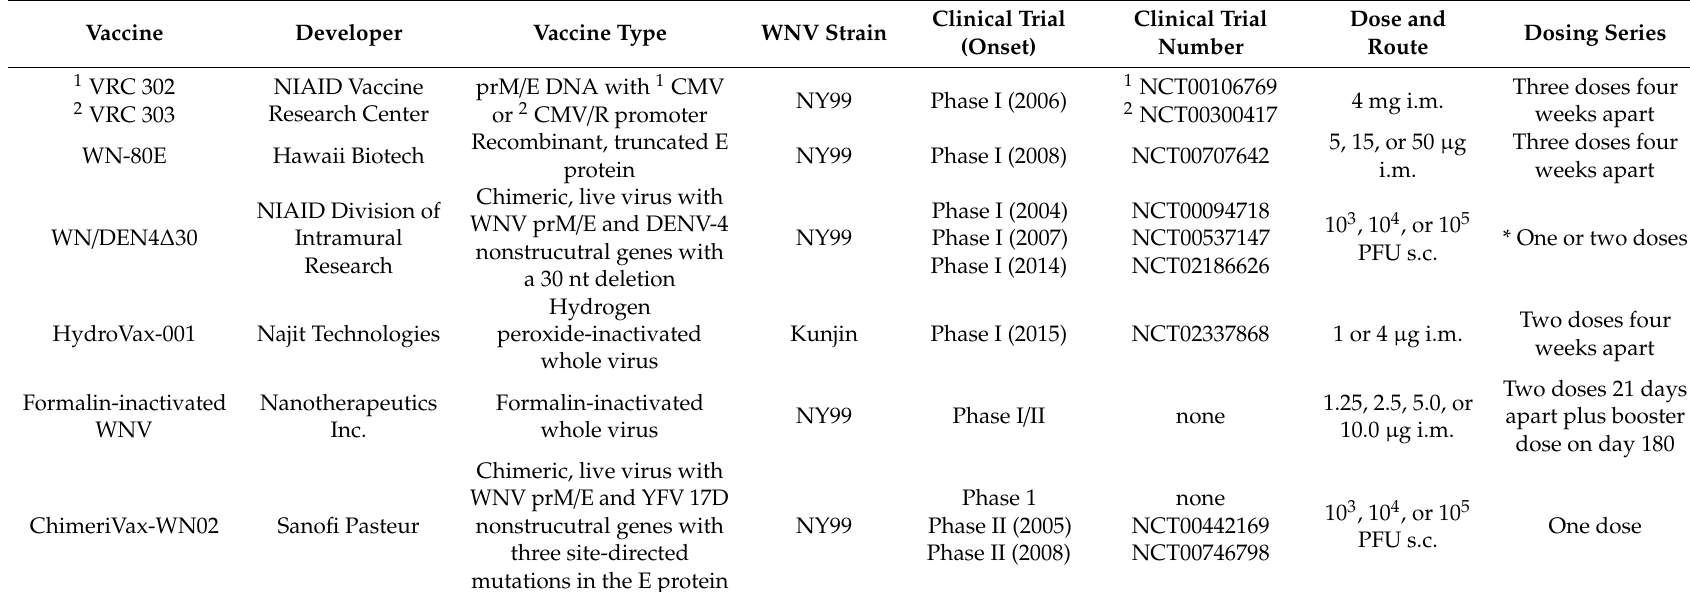
Table 1. Summary of WNV vaccine candidates that have been studied in clinical